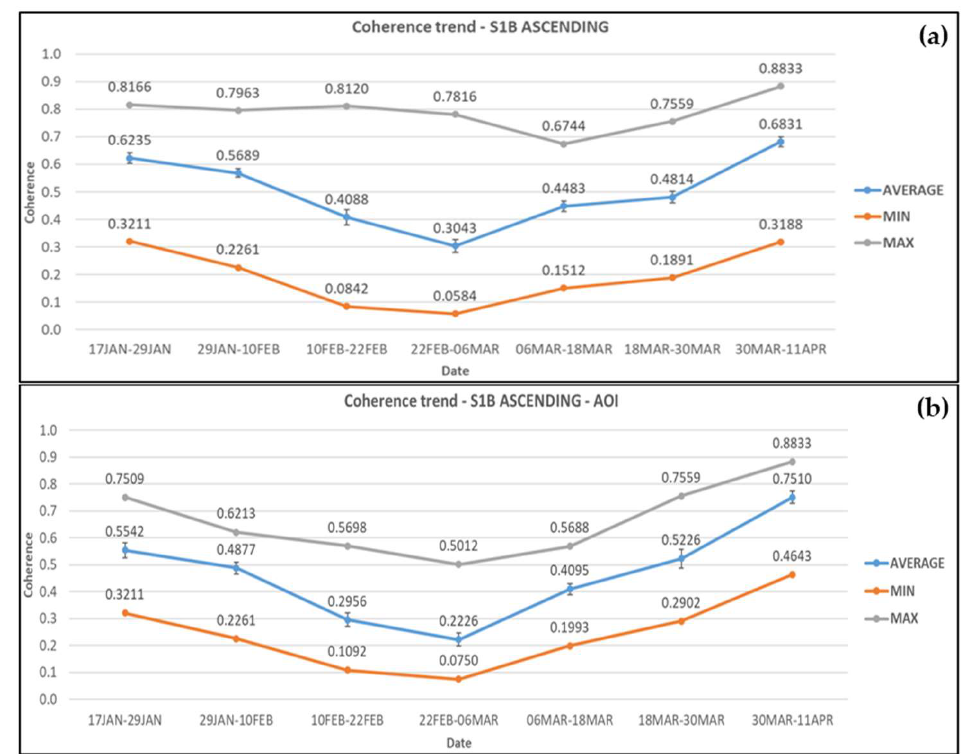
Figure 7. Coherence changes obtained from Sentinel-1B ascending satellite images for ( a ) the wider area and ( b ) the AOI. Error bars can be seen in the average coherence values.